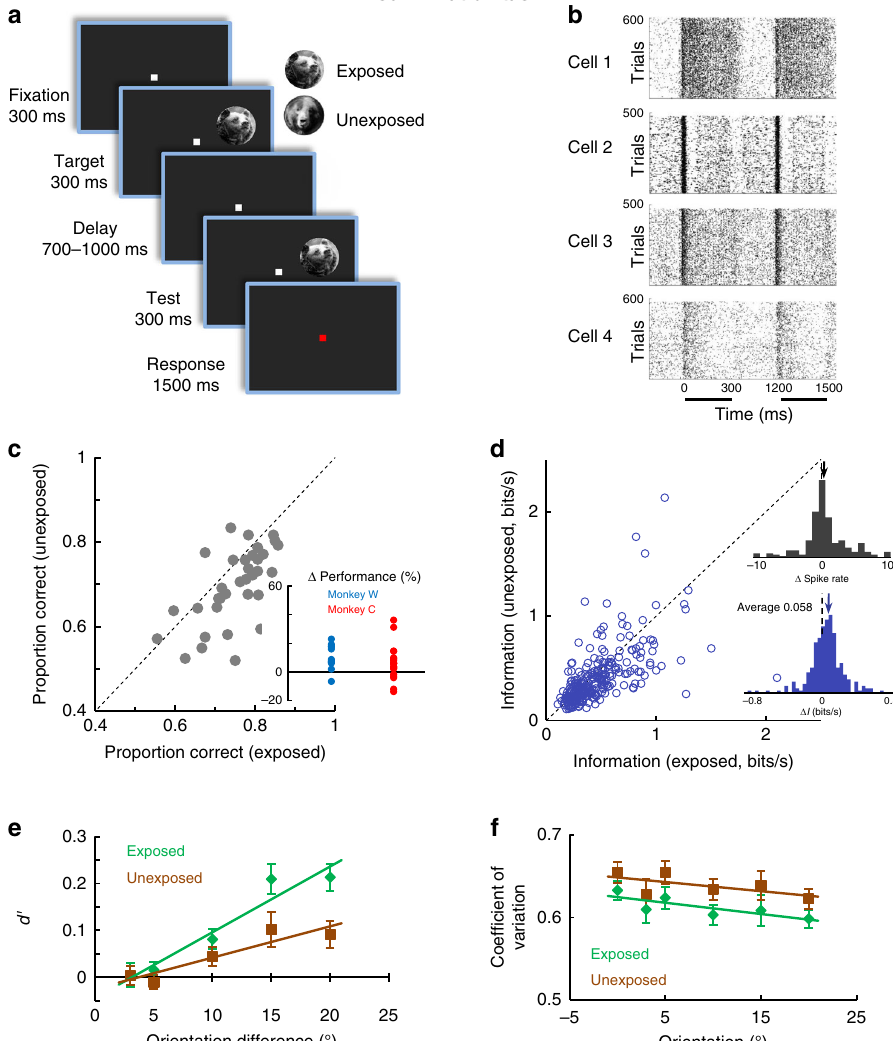
Fig. 3 Exposure improves neural coding in V1. a Cartoon describing the discrimination task — monkeys are required to report whether two successively fl ashed images (target and test) differed or not in orientation (images were rotated by 0, 3, 5, 10, or 20°). Exposed and unexposed image trials were randomly interleaved (in 50% of trials the two images were not rotated with respect to each other). b Raster plots for example neurons recorded during image orientation discrimination task. The dark bars mark the stimulus presentation. c Proportion of total correct responses in the image discrimination task for the exposed vs. the unexposed image conditions. Each point is associated with a pair of images in one session ( P = 0.00012, n = 34, Wilcoxon sign-rank test). Inset represents the change in perceptual performance in the exposed vs. unexposed conditions for each monkey. d Neurons transmit more information about the exposed images relative to unexposed images ( P = 2.61 × 10 − 8 , Wilcoxon sign-rank test, 300 ms, n = 263). Each point represents mutual information for a single neuron associated with the exposed ( x axis) and unexposed ( y axis) stimuli. (insets) (top) Distribution of fi ring rate elicited by the exposed and unexposed images. There are no signi fi cant changes in mean responses between the exposed and unexposed conditions.